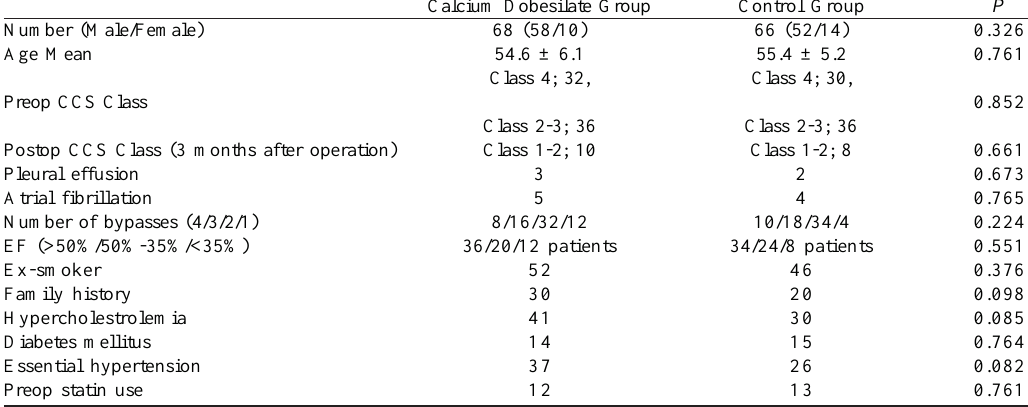
Table 1. Characteristics of patients in calcium dobesilate group and control